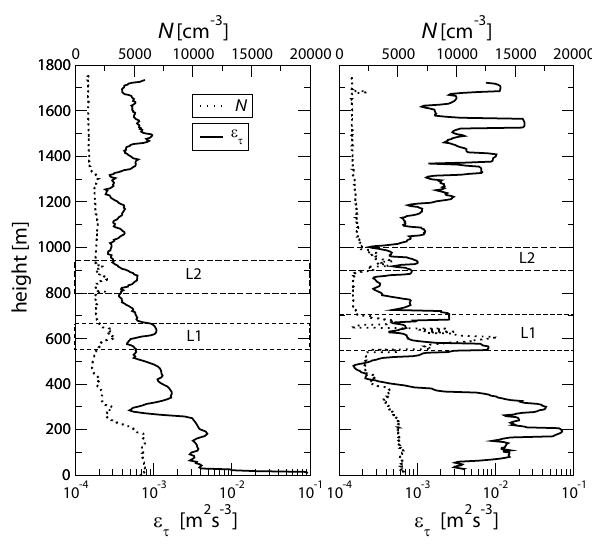
Fig. 8. Vertical profiles of the local energy dissipation rate ε τ (solid lines) and the particle number concentration N (dotted lines) for profile 1 (left) and profile 3 (right). Energy dissipation is esti- mated from second-order structure functions over non-overlapping sub-records of τ =